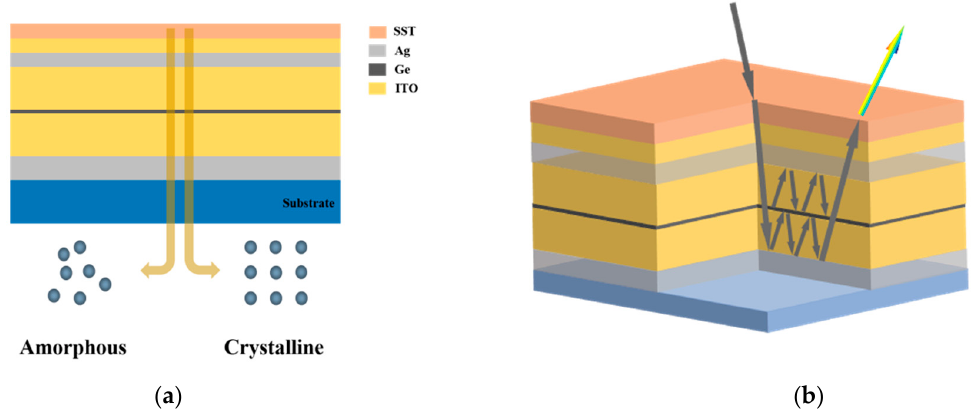
Figure 3. ( a ) Structural of the multi-order F–P cavity resonance; ( b ) three-dimensional model and schematic diagram of the F–P resonator.